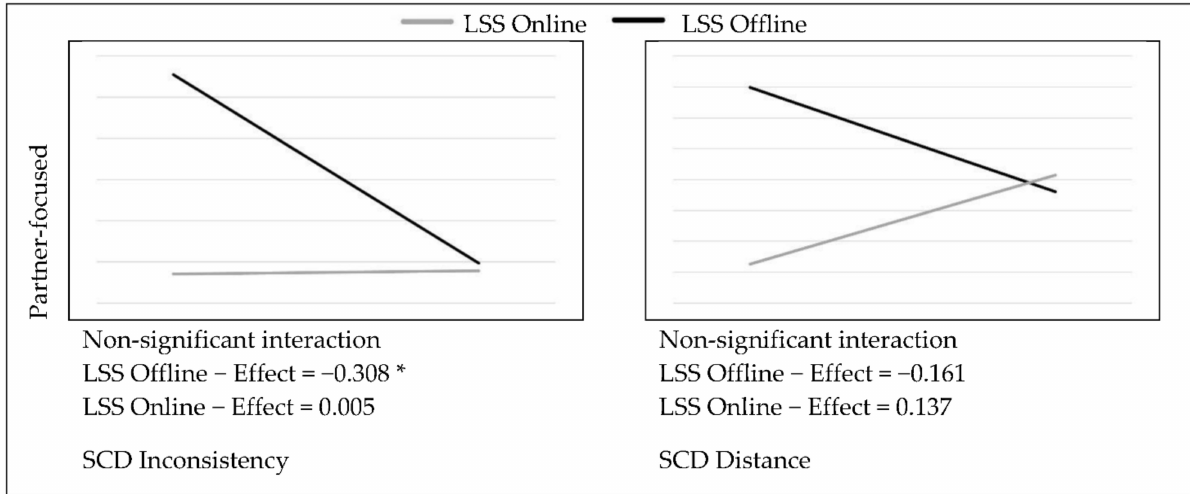
Figure 3. Effects of SCD on sexual satisfaction (standardized means). * p <